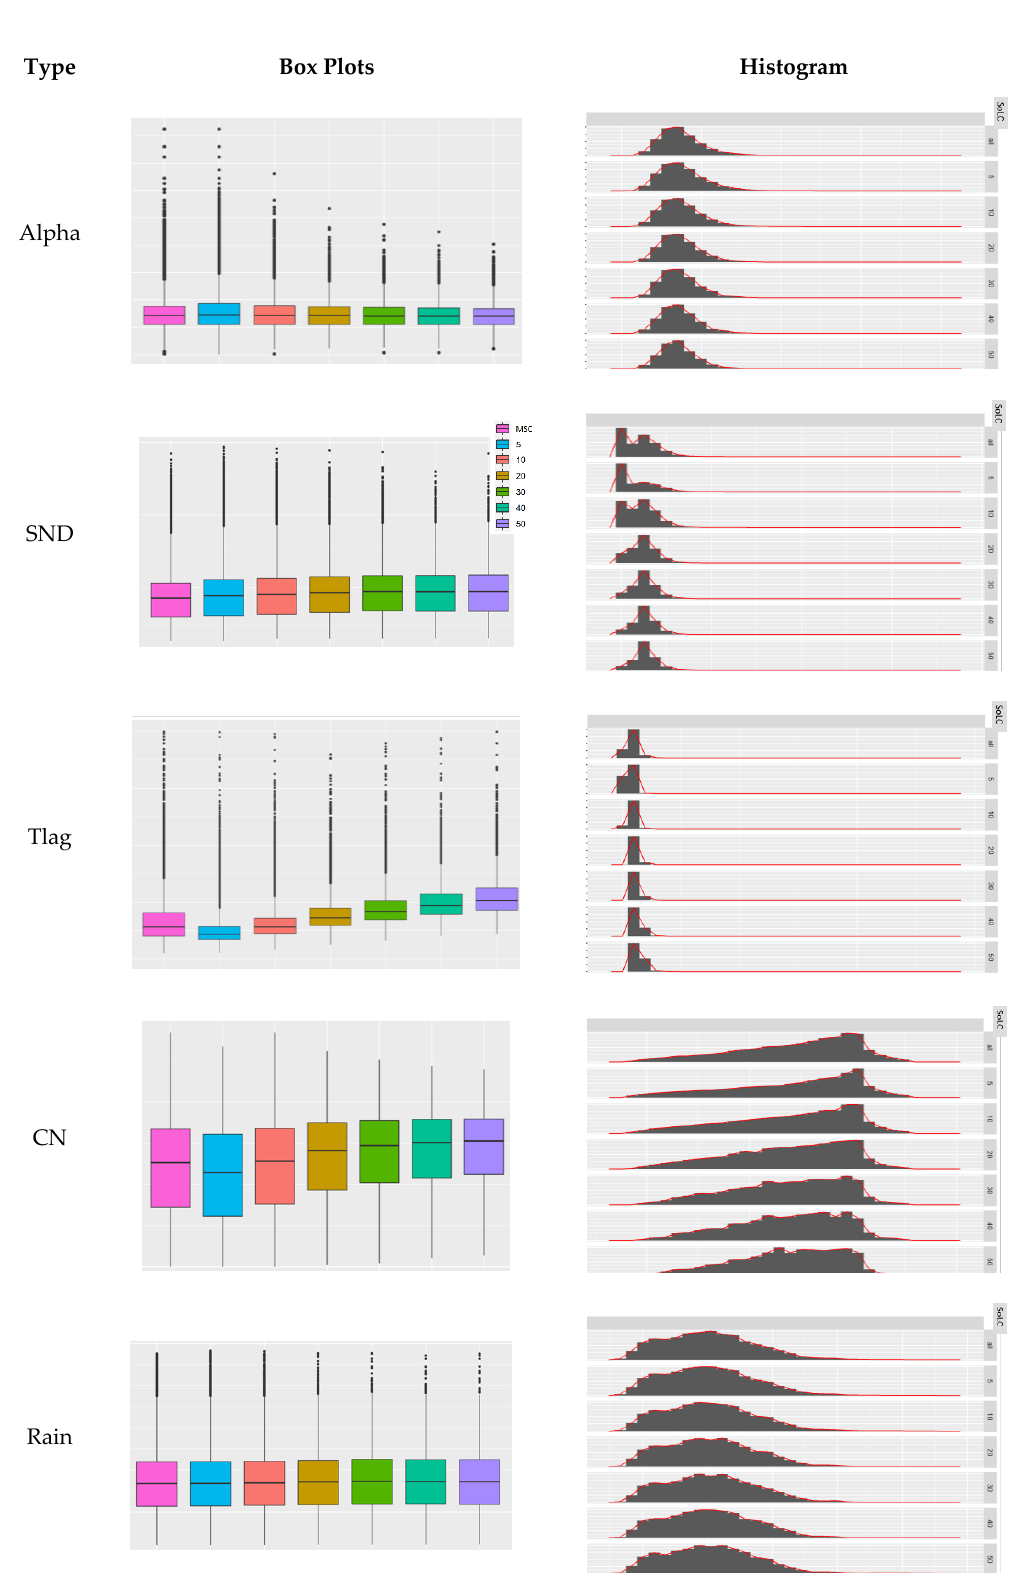
Figure 6. The left column displays the box plots showing the median value, the interquartile range, and the 25 or 75 quartiles of the values. The right column displays the frequency histograms in each class. The values in the histograms are normalized to achieve a comparable number of values in each catchment size